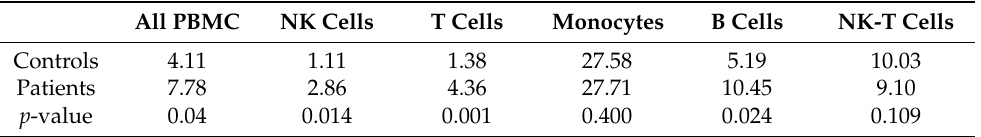
Figure 2. Box plot of the average number of PNPs bound per PBMC subtype for 14 serous invasive cancer patients and 7 healthy controls. p -values were obtained using the non-parametric Mann–Whitney U-test. We observe a statistically significant elevation of binding on NK cells, T cells, B cells and all cells. The Y-axis is different between box plots due to the different binding patterns per cell subtype. Table 2. Average number of PNPs bound per cell subtype for serous invasive ovarian cancer patients and healthy controls. P -values are computed using the non-parametric Mann–Whitney U- test.